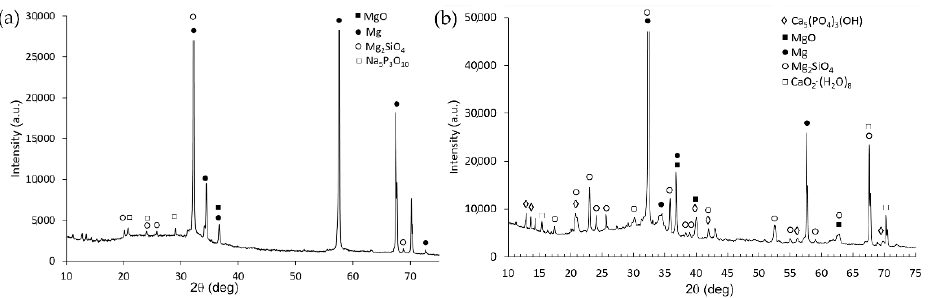
Figure 3. X ‐ ray diffraction (XRD) pattern of the sample PEO treated ( a ) and PEO ‐ BIO ( b ) samples. Figure 3. X-ray diffraction (XRD) pattern of the sample PEO treated ( a ) and PEO-BIO ( b )